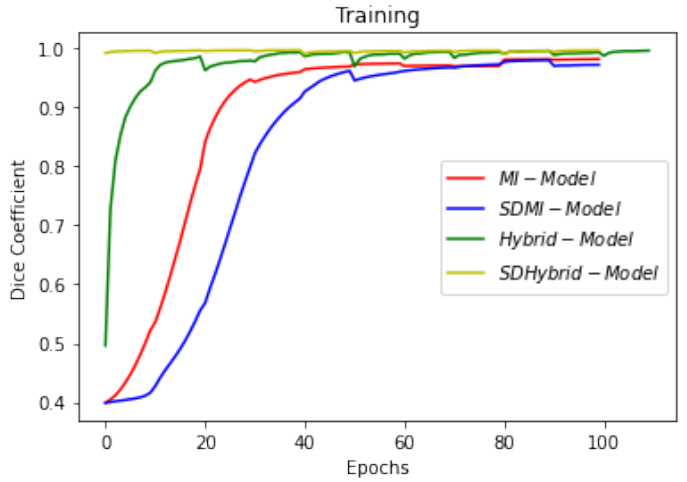
Figure 19. Comparison of Training Dice Coefficient.